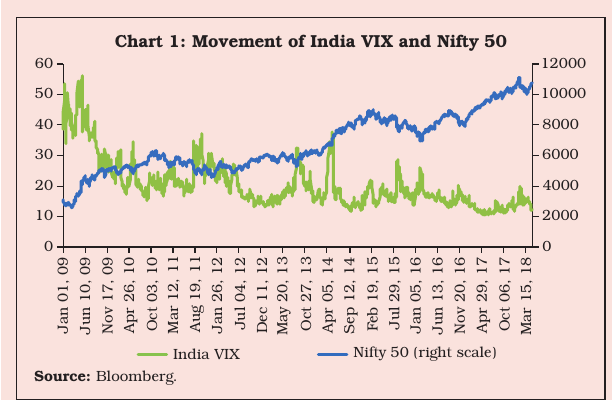
Chart 1: Movement of India VIX and Nifty 50